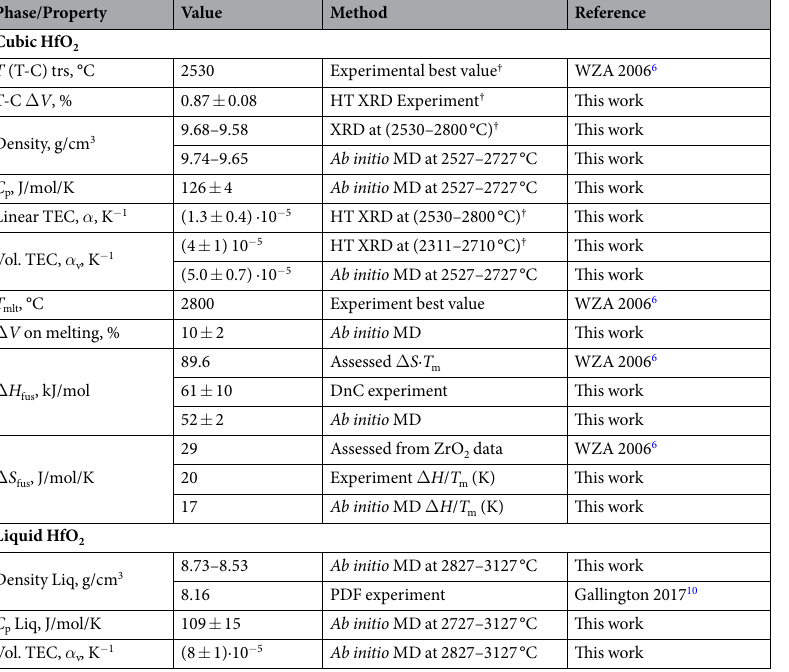
Table 3. Thermodynamic data for cubic and liquid HfO 2 . † Best values for HfO 2 tetragonal–cubic (T-C) transition and melting from WZA 06 assessment of experimental results (2530 and 2800 °C) were used for temperature calibration in diffraction experiments in this work. (TEC: Thermal Expansion Coefficient, Vol.: